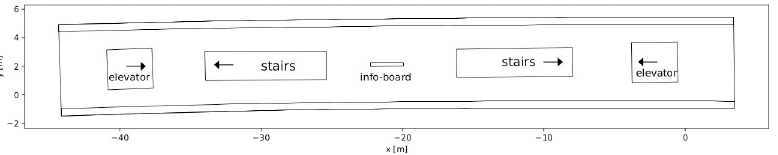
Fig 1. Spatial structure of the measurement area at the railway platform of Zu¨rich Hardbru¨cke. Arrows indicate the movement direction for pedestrians entering the platform. The measurement area covers approximately 50 m of the